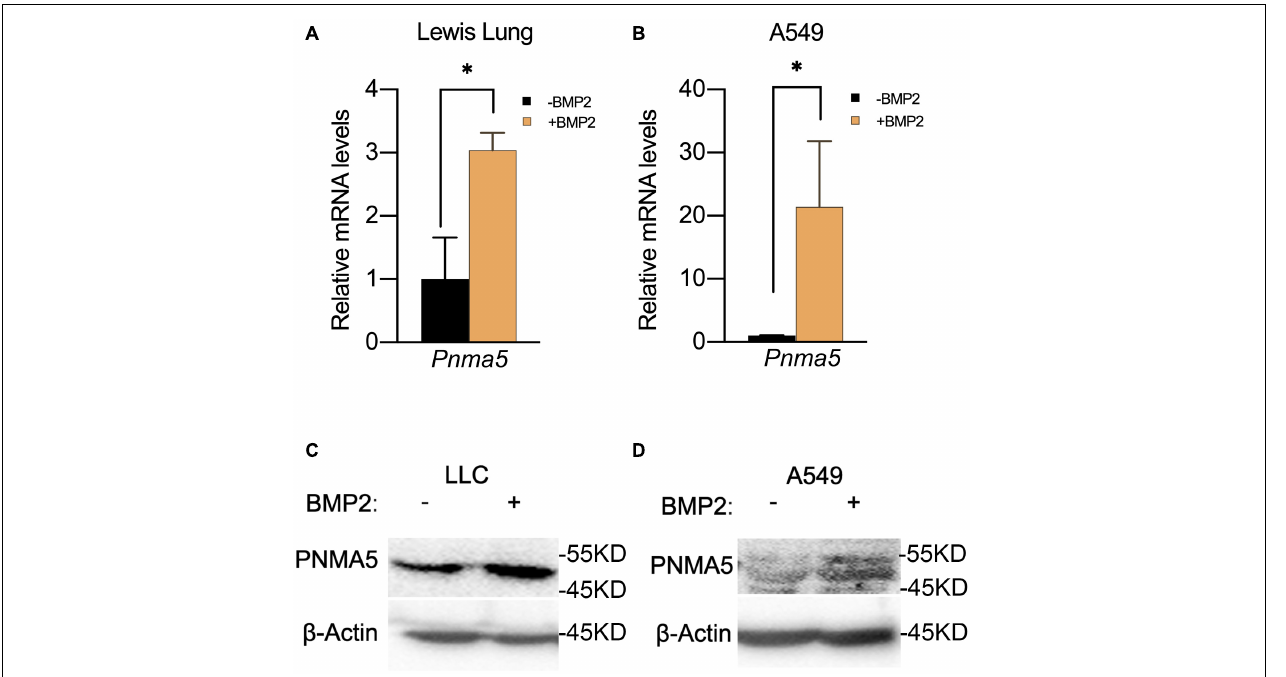
FIGURE 2 | BMP2 signaling activation induced the expression of PNMA5. (A) Comparison of relative Pnma5 mRNA levels of LLC cells with or without BMP2 treatment by qPCR. * P < 0.05. (B) Comparison of relative Pnma5 mRNA levels of A549 cells with or without BMP2 treatment by qPCR. * P < 0.05. (C) LLC cells treated with or without BMP2 for 1 h. Lysates of the indicated treated LLC cells were harvested to be subjected to western blot for PNMA5. β -Actin was the reference for all the blots. (D) A549 cells treated with or without BMP2 for 1 h. Lysates of the indicated treated A549 cells were harvested to be subjected to western blot for PNMA5. β -Actin was the reference for all the